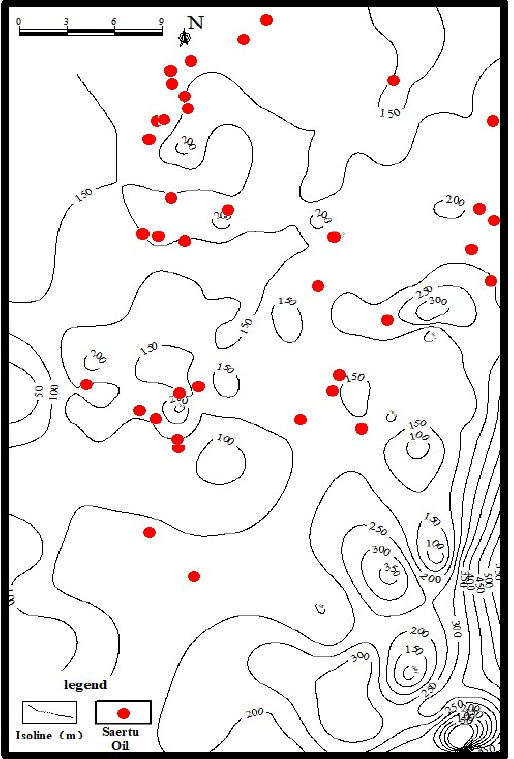
Figure 9. Thickness of mudstone cap rock at Nen-2 member in the Bayan Chagan Area.